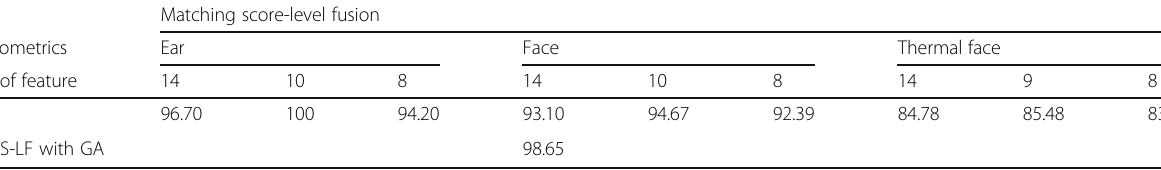
Table 7 Matching score-level fusion with